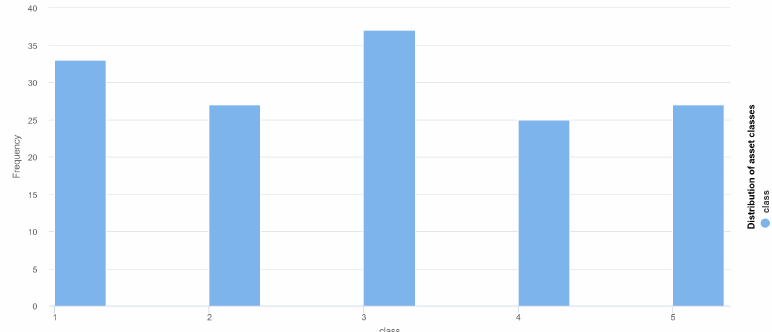
Figure 5. Distribution of asset